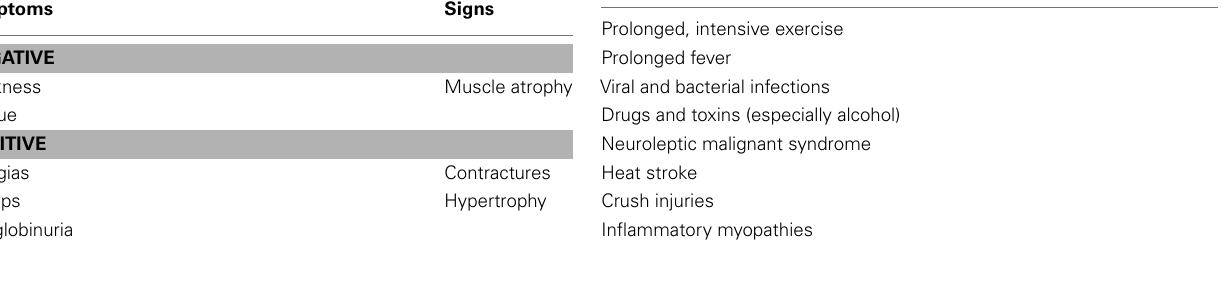
Table 3 | Symptoms and signs associated with systemic myopathies.